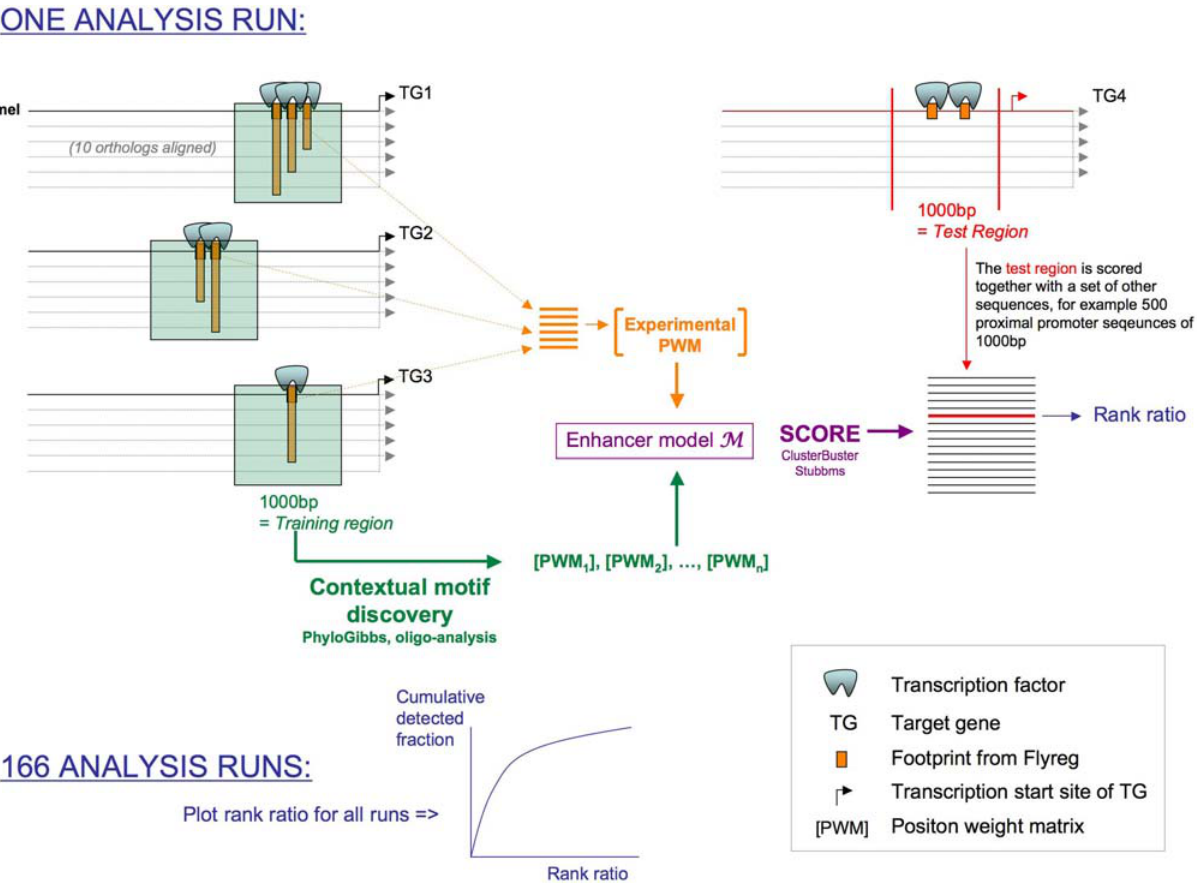
Figure 1. LOOCV assessment scheme. An enhancer model, consisting of one or more PWMs, is trained on known target regions of a TF, excluding the target region of the test TG (here TG4 is excluded). This left-out region, together with a set of negative sequences, is scored with the enhancer model. All 166 rank ratio’s are plotted cumulatively.